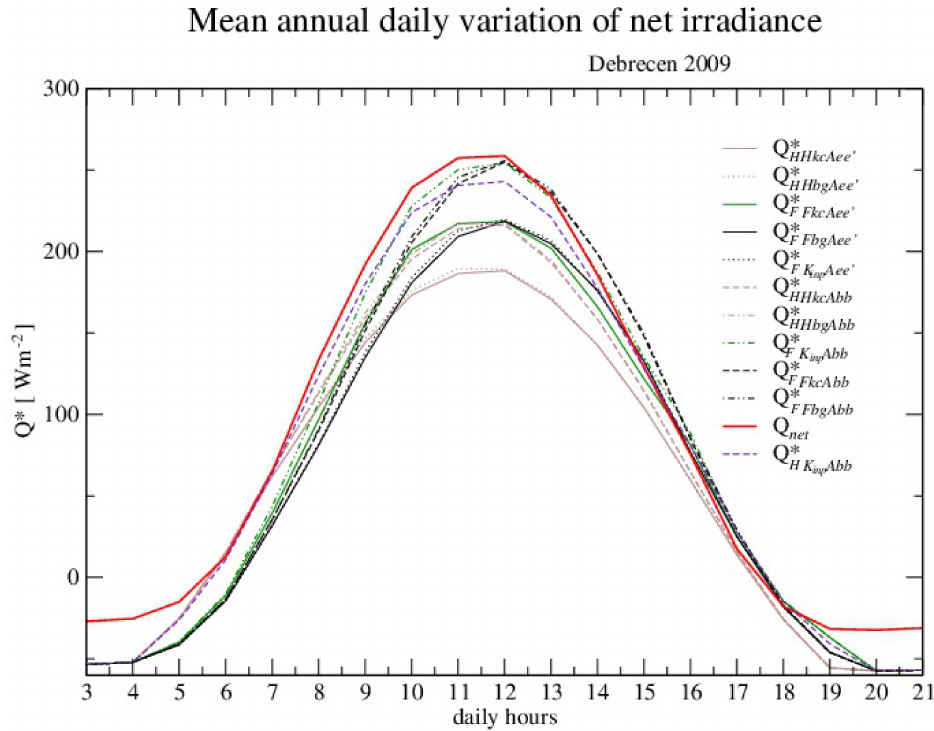
Figure 5. Mean annual daily variation of net irradiance Q ∗ . Notation similar to Table